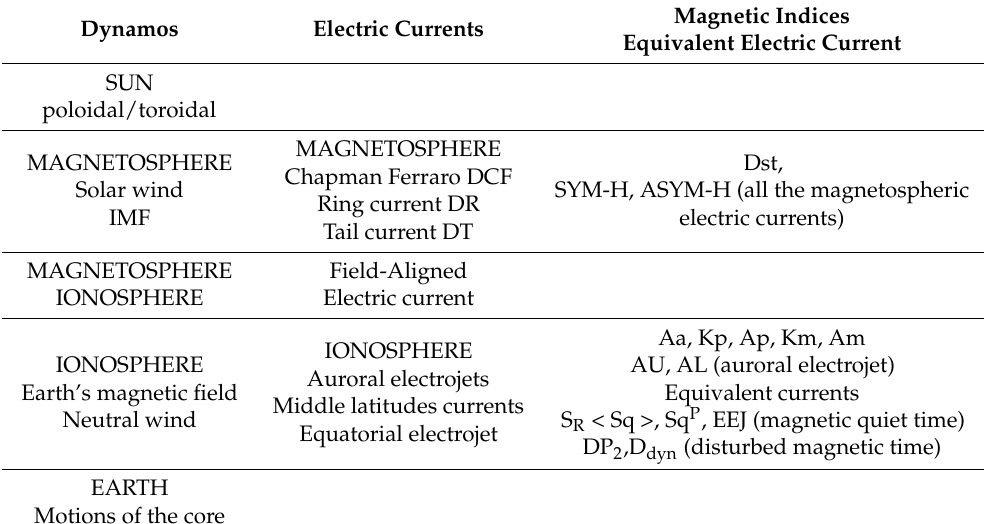
Table 2. Dynamos, electric currents, and magnetic